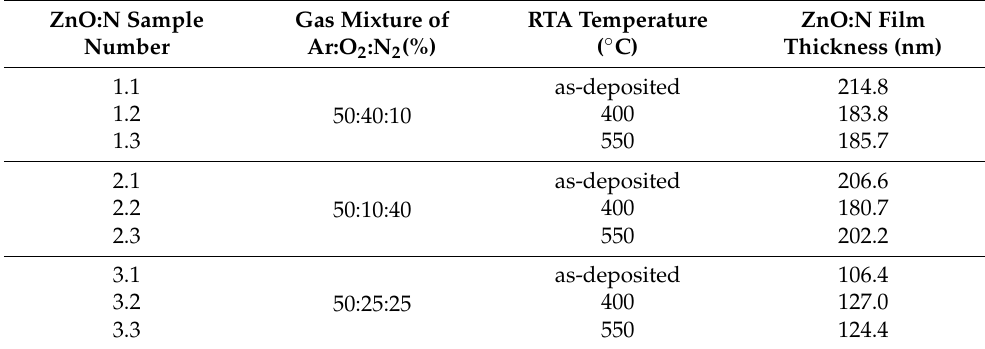
Table 1. Technological conditions and corresponding sample number of ZnO:N films with the given layer’s